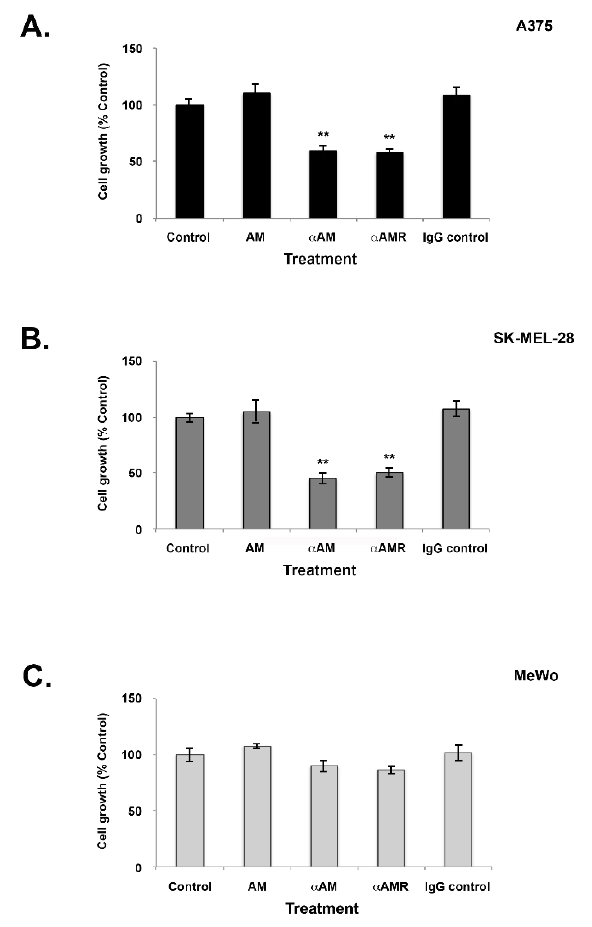
Figure 3. Effect of AM on in vitro growth of melanoma cells. ( A – C ) Cells were seeded at densities of 1 × 10 3 (A375), 2 × 10 3 (SK-MEL-28), and 4 × 10 3 (MeWo) per well for the proliferation assay in 24 multiwell plates using a growth medium containing 2% of fetal bovine serum. AM (10 − 7 M), α AM (70 μ g/mL), α AMRs (70 μ g/mL), or control IgG (70 μ g/mL) was added to the cells for 6 days of treatment. Six wells were prepared for each treatment for 3-(4,5-dimethylthiazol-2-yl)-2,5-diphenyl- tetrazolium bromide (MTT) analysis. ** p < 0.01. The values represent the mean ± SD of five inde- pendent experiments, each performed in triplicate.